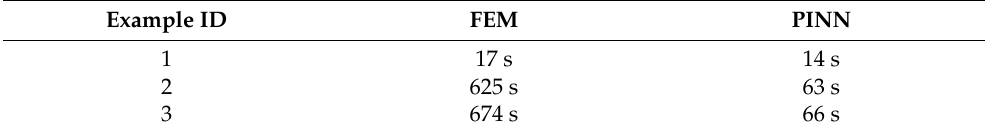
Table 2. Inversion times for different examples using the FEM and PINN methods. Example